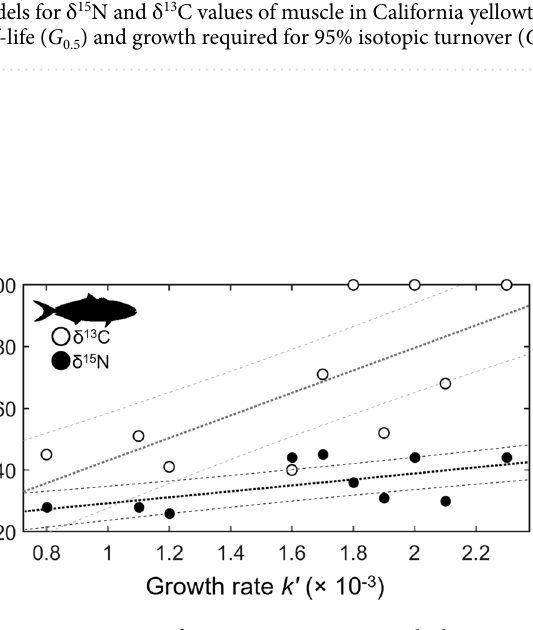
Table 4. Parameter estimates and 95% confidence intervals for relative growth-based ( W R ) exponential fit models for δ 15 N and δ 13 C values of muscle in California yellowtail ( Seriola dorsalis ). Estimated growth-based half-life ( G 0.5 ) and growth required for 95% isotopic turnover ( G 0.95 ) is shown for each isotope.